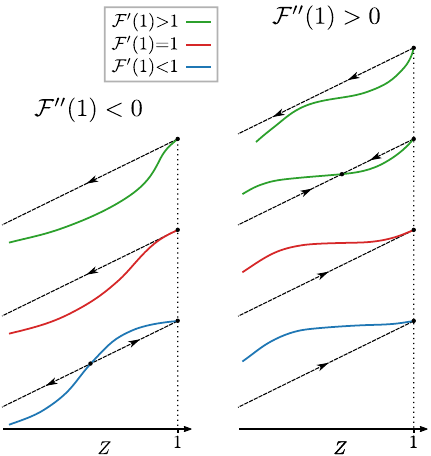
1 , in two different scenarios =